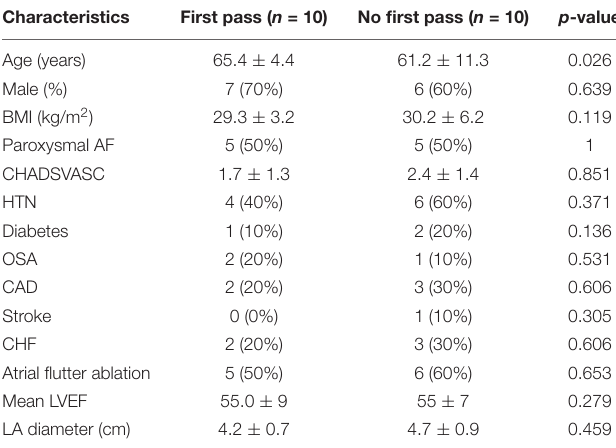
TABLE 2 | Comparison of mean segmental bipolar voltage in two